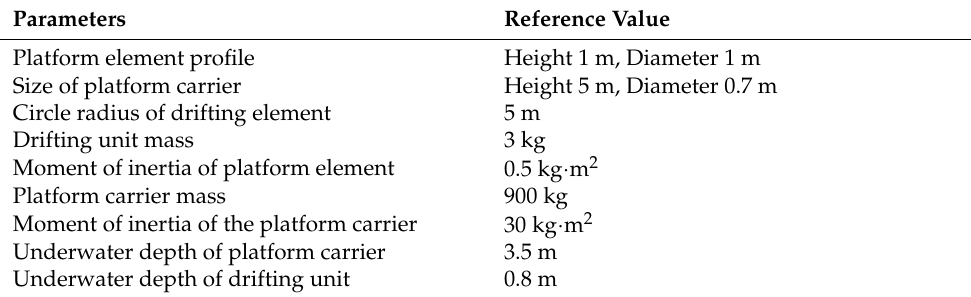
Table 1. Structural parameters of platform.